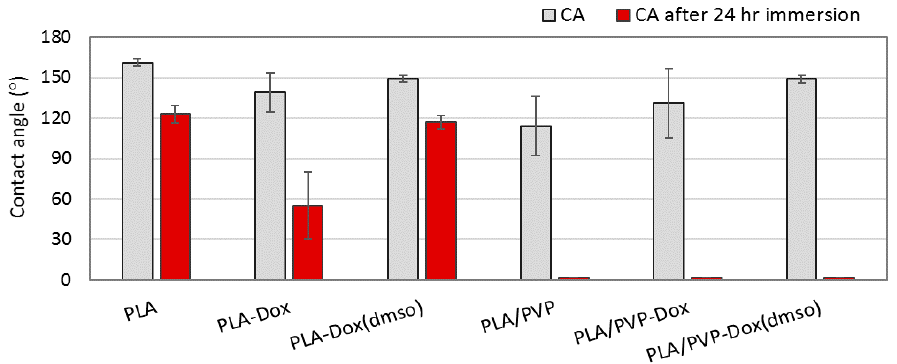
Figure 6. Contact angle of Dox-loaded fiber webs before and after immersion in water for 24 h.